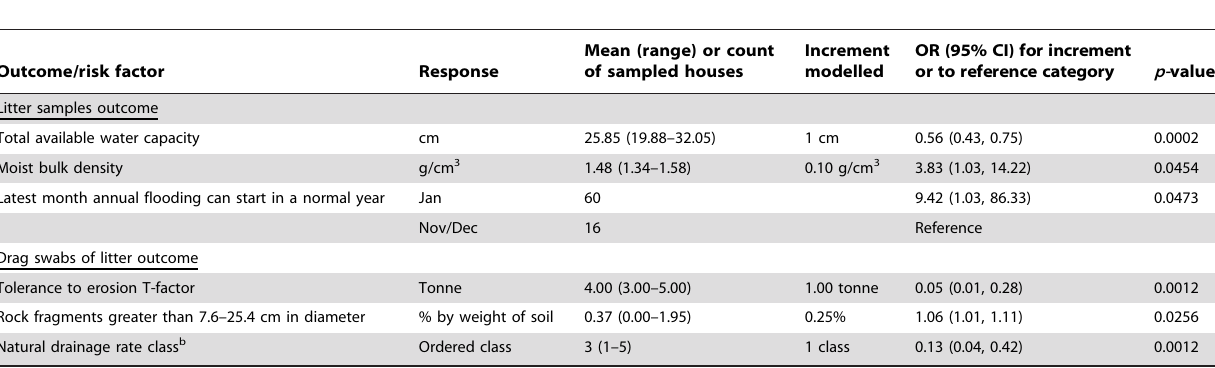
Table 2. Fixed effects risk factors in the final models of soil properties at broiler grow-out farm location associated with probabilities of detecting Salmonella in the samples and drags swabs of litter (n =76) a